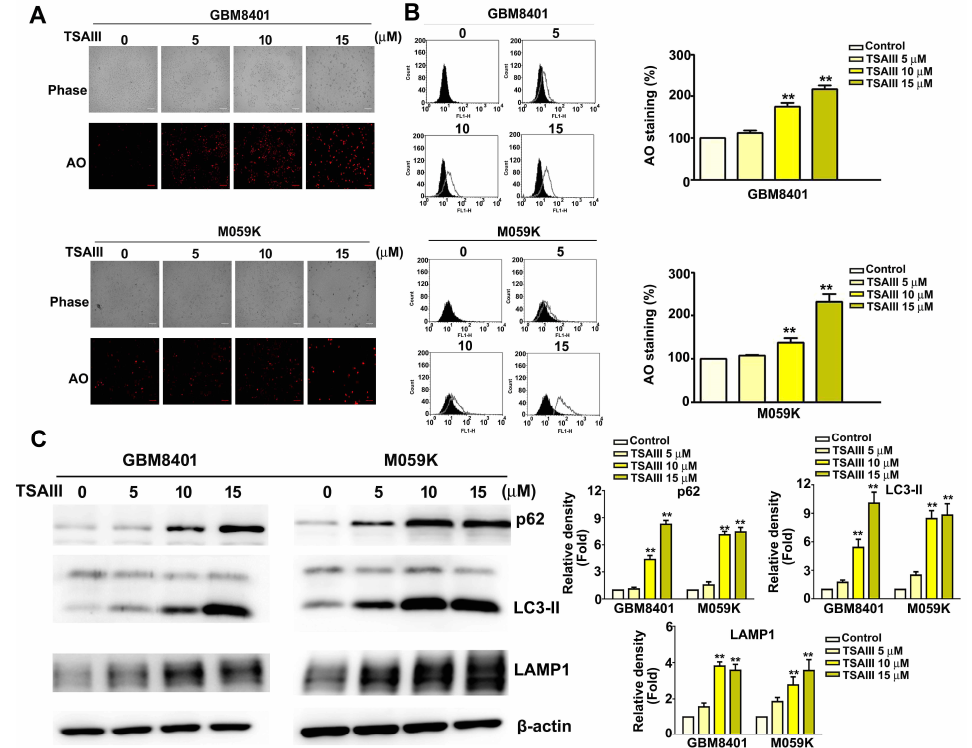
Figure 4. TSAIII induces autophagy and autophagy-related protein expression in human glioma cells. ( A ) Representative fluorescence micrographs of AO staining in GBM8401 and M059K cells treated with various concentrations of TSAIII (0, 5, 10, 15 µ M) for 24 h. ( B ) Quantitative results of flow cytometry with AO staining. ( C ) Western blot analysis of protein expression of the autophagy markers p62 and LC3-II and the lysosome marker LAMP1. Quantification of band density was performed using ImageJ. Each experiment was repeated three times, and data are presented as the mean ± SE. ** p < 0.01 vs. untreated cells (control).